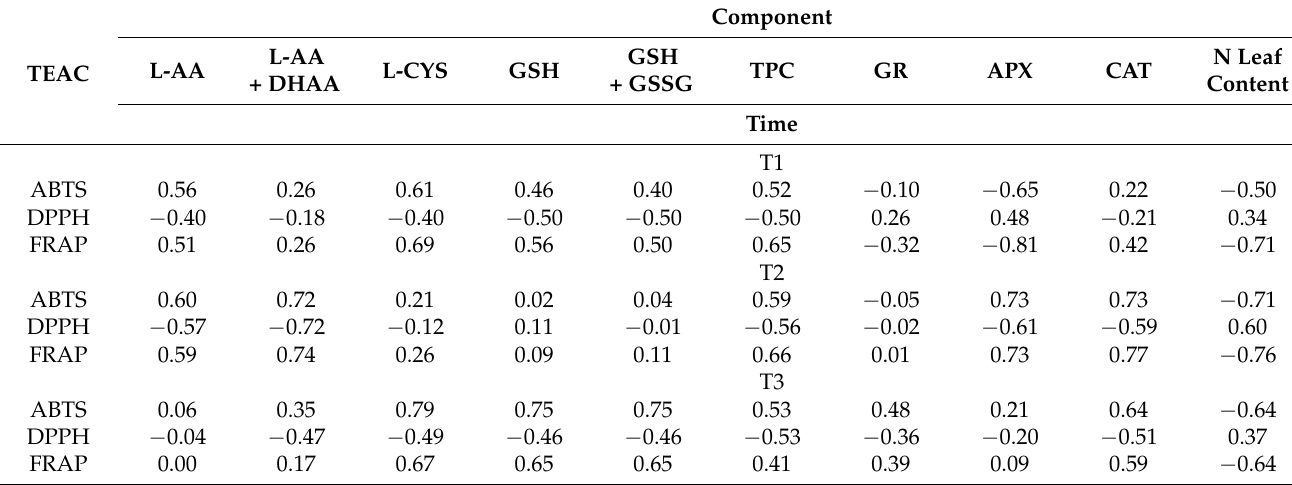
Table 2. Correlation coefficient between the individual antioxidant tested and total antioxidant capacity (TEAC) during the 2015 growing season made across two cultivars.